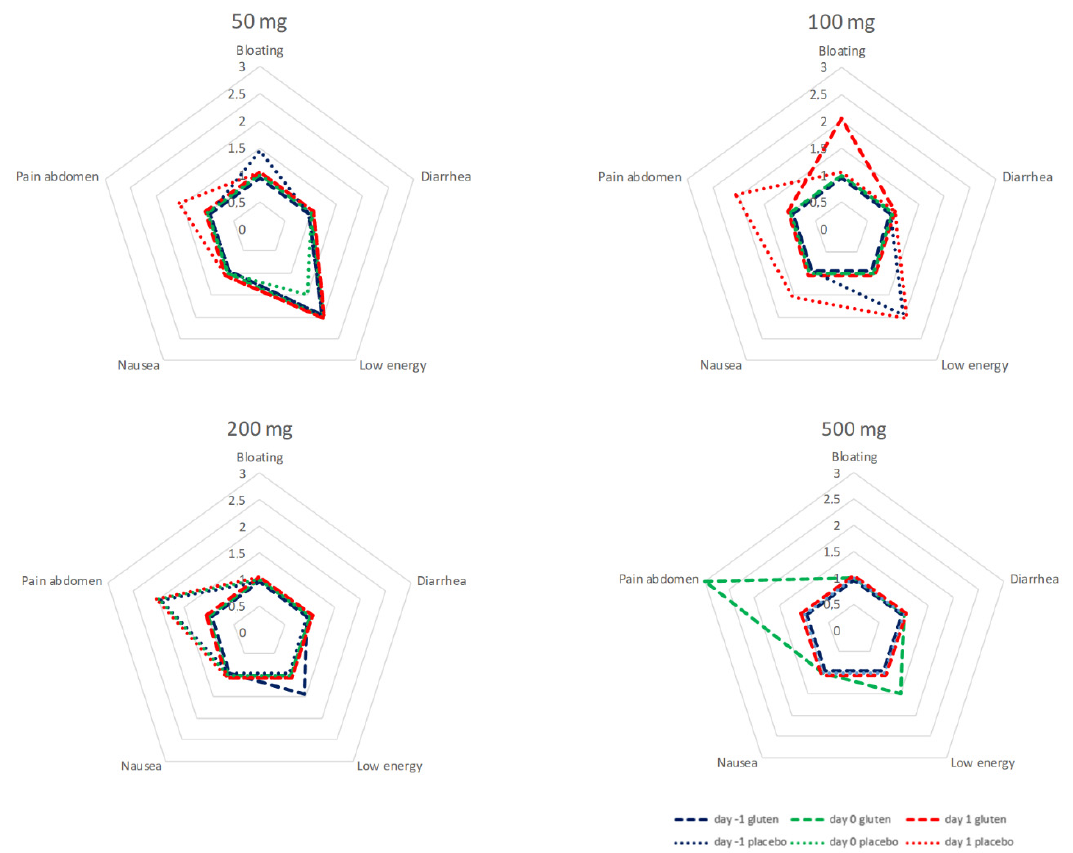
Figure 5. Symptoms from 24 h before until 48 h after ingestion of 50 mg of gluten and placebo. All patients that had received gluten were included irrespective of GIP in urine. Only patients that had negative urine for GIP after placebo were included. x -axis: the median answer on the 5-point Likert-scale (ranging from none of the time (0 points), a little of the time (1 point), some of the time (2 points), most of the time (3 points) and all of the time (4 points)) per cycle.